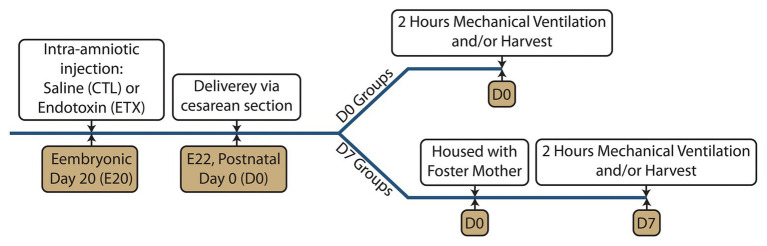
Experimental timeline showing the intra-amniotic injection at embryonic day 20 (E20), delivery via cesarean section at E22, and mechanical ventilation at postnatal day 0 (D0 groups) or postnatal day 7 (D7 groups).